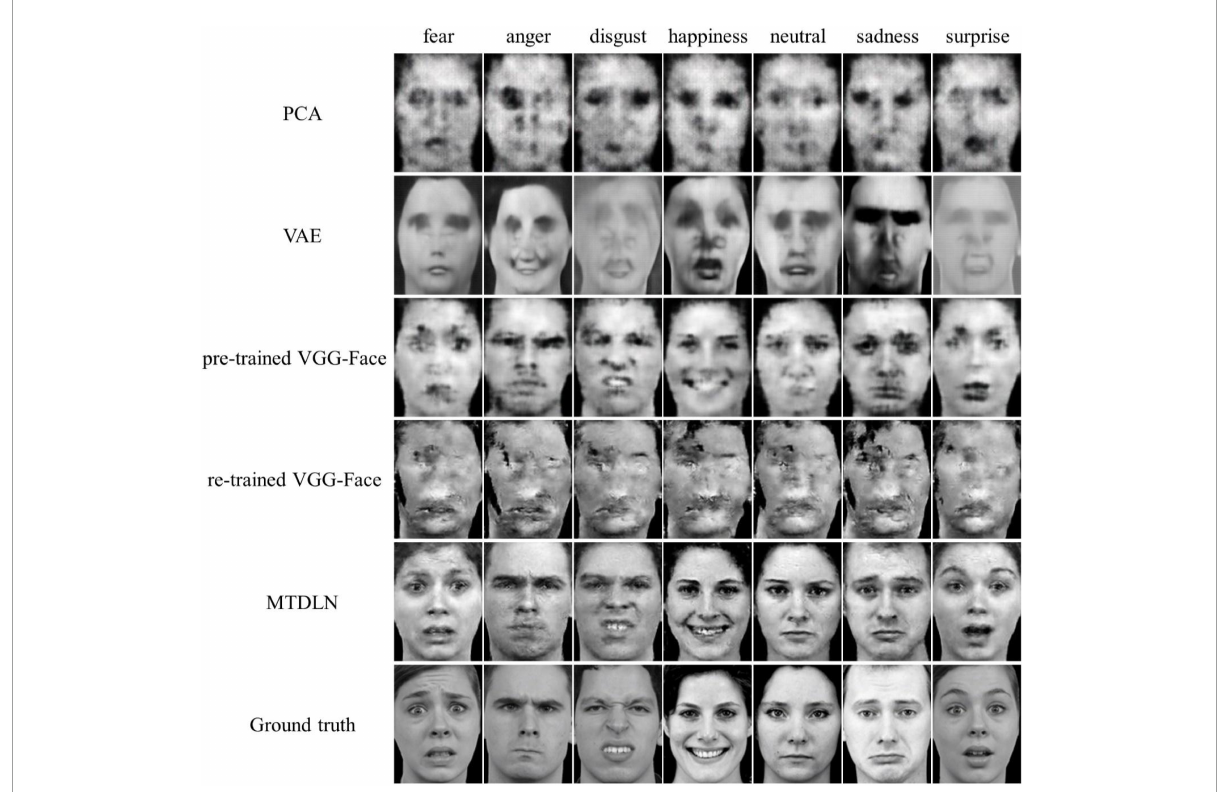
FIGURE4 Representative samples of reconstructed faces from five different feature-extraction models. From top row to bottom row: PCA, VAE (VanRullen and Reddy, 2019), pre-trained VGG-Face, re-trained VGG-Face, multi-task deep learning network (MTDLN), and Ground